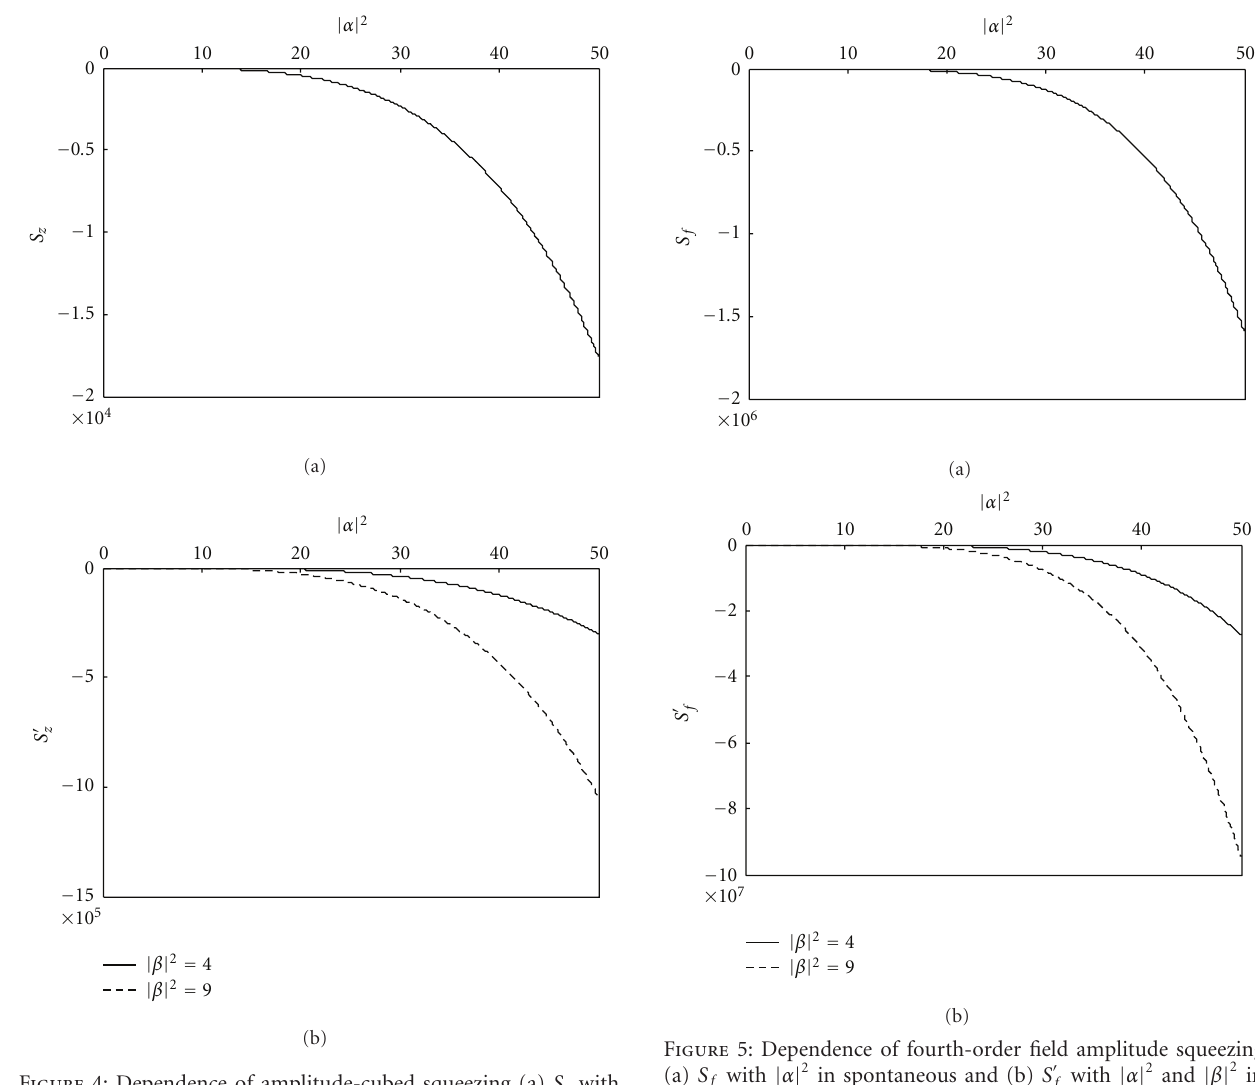
Figure 4: Dependence of amplitude-cubed squeezing (a) S z with | α | 2 in spontaneous and (b) S (cid:6) with | α | 2 and | β | 2 in stimulated six- z wave mixing process.